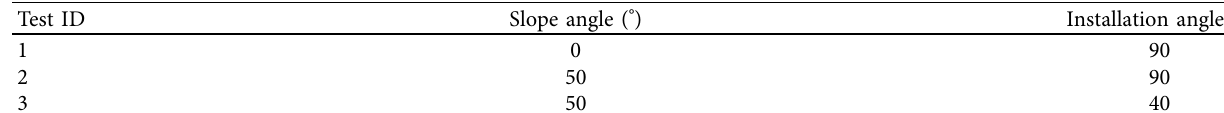
Figure 8: The distribution of the normal impact loads at the moment of maximum normal impact loads: (a) tilted wall and (b) vertical wall. Table 3: The slope angle and installation angle of each test.